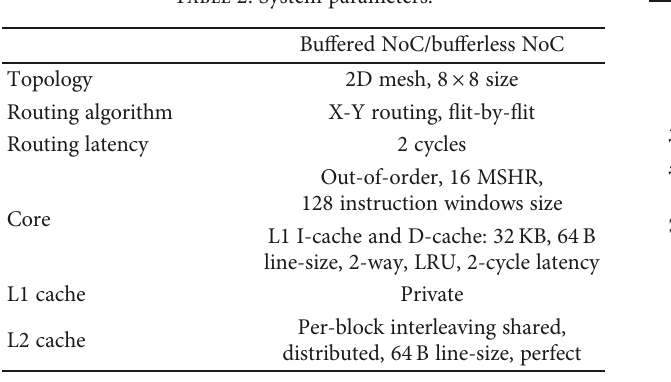
Table 2: System parameters.